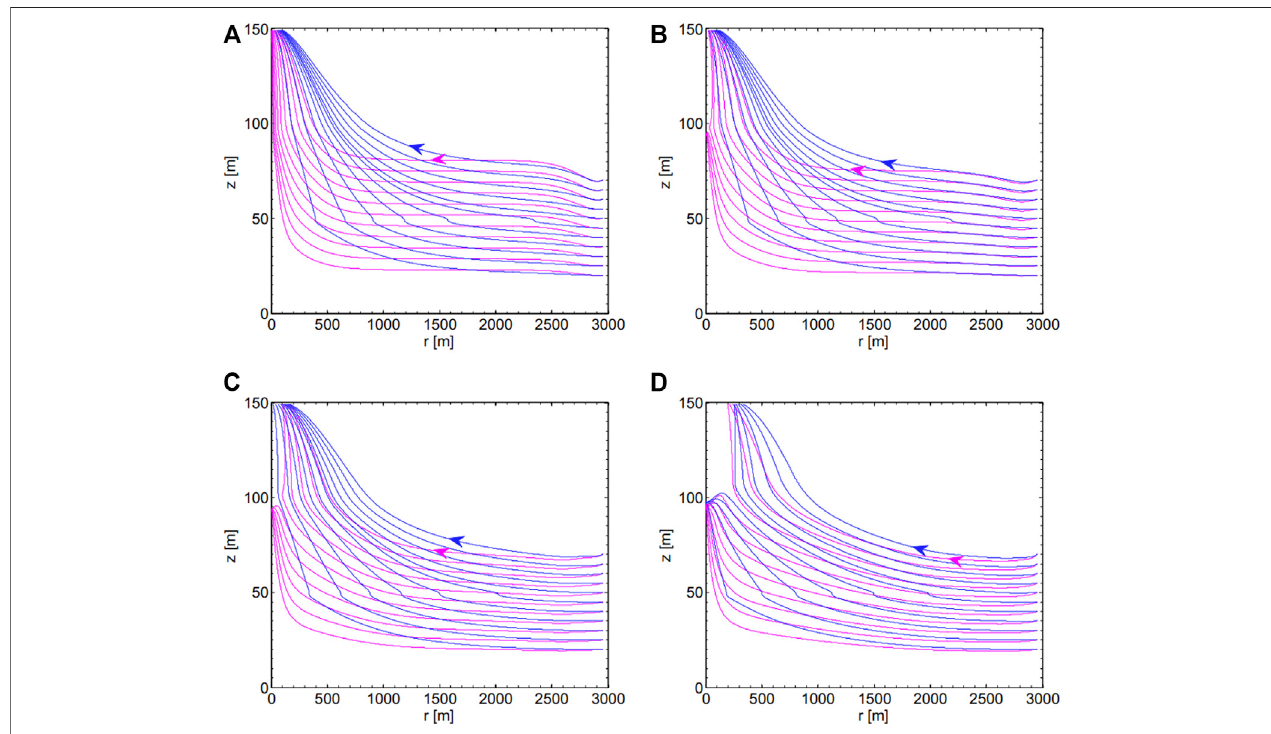
FIGURE 2 | Streamlines developed in the homogeneous case (magenta) and the layered case (blue) after (A) 1 year, (B) 2 years, (C) 5 years, and (D) 20 years.